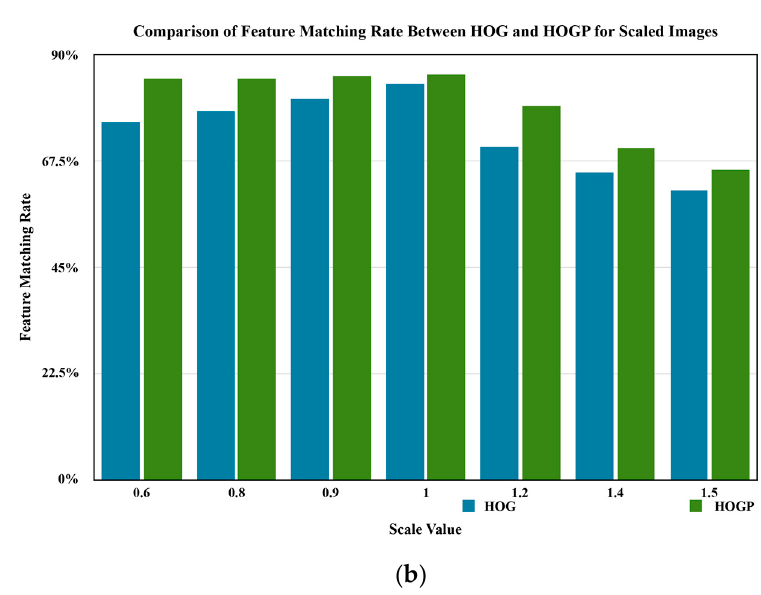
Figure 13. The comparison result between HOG and HOGP with respect to the feature matching rate. ( a ) Rotated images; ( b ) scaled images. Figure 11 indicates the object detection results of the rotated images based on HOGP. Compared